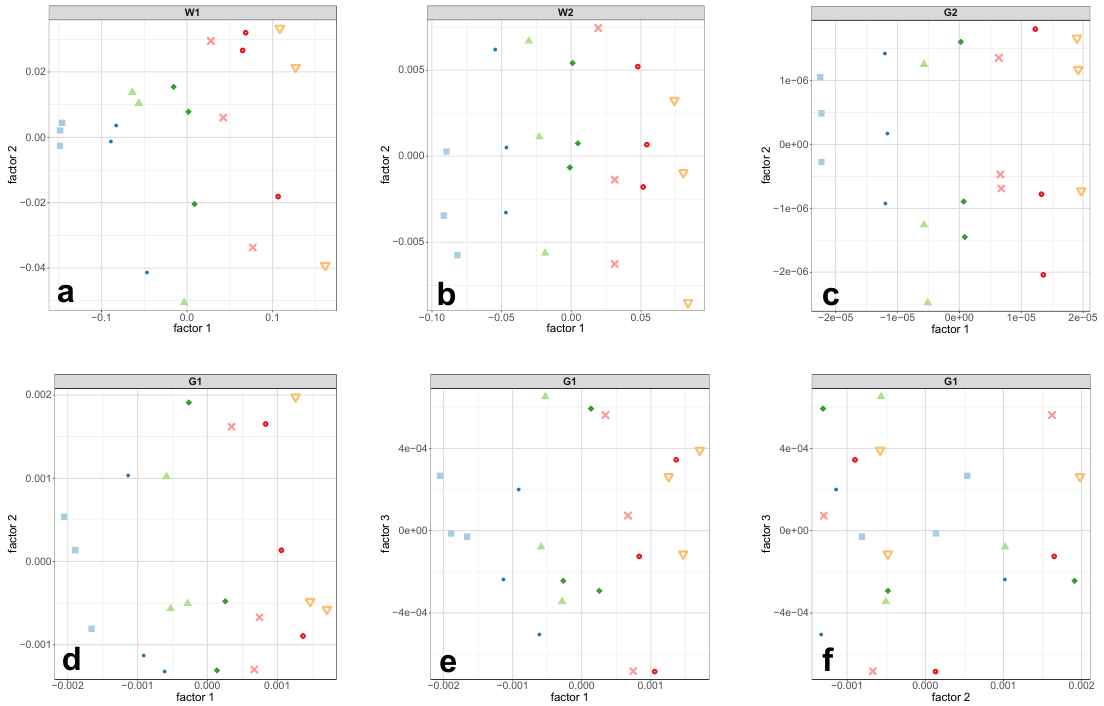
Figure 5. PLS-R score plots of the calibration set for the regions W1 ( a ), W2 ( b ), G2 ( c ), and G1 ( d – f ) obtained by measurements with the 0.1 mm cell. Each data point corresponds to one batch. The featured factors were chosen according to the required number of PLS-R factors in Table